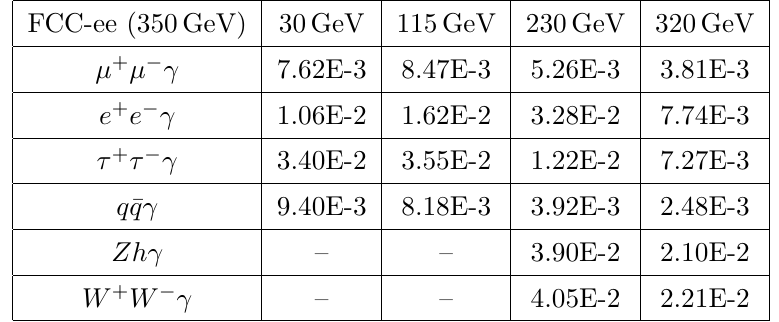
p Table 4 . The values of (cid:15) corresponding to S= B = 2 for m A 0 = 30 GeV, 115 GeV, 230 GeV and 320 GeV in di(cid:11)erent channels at the 350 GeV FCC-ee with the integrated luminosity of 1 : 5 ab (cid:0) 1 . The notation of \aE-b" stands for a (cid:2) 10 (cid:0) b . FCC-ee (160 GeV) 30 GeV 70 GeV 115 GeV (cid:22) + (cid:22) (cid:0) (cid:13)